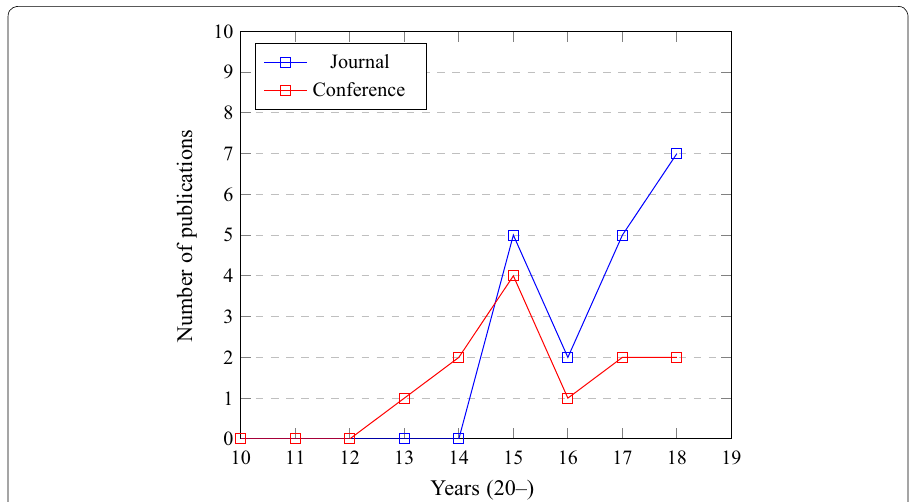
Fig. 5 Year-on-year publication growth in journals and conferences. The figure shows the distribtion of the proposed methods in journals and conferences during the last 10 years